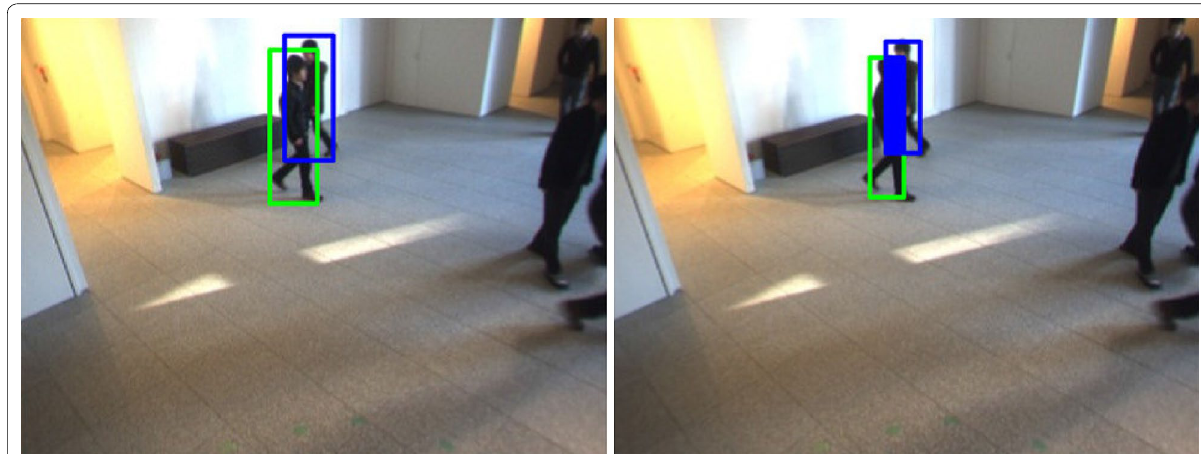
Fig. 9 Occlusion detection. The left image represents an original image. The right image represents occluded blocks, colored blue